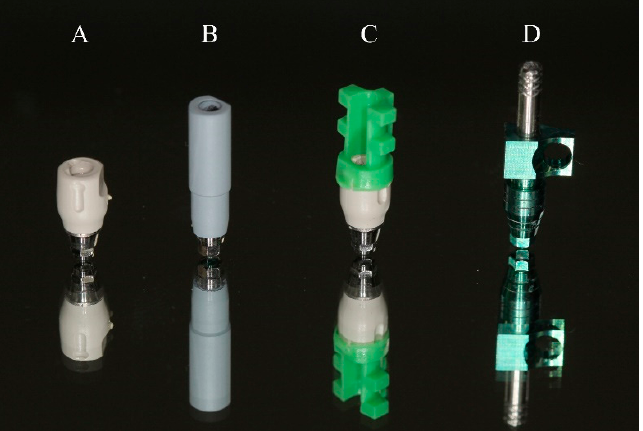
Figure 3. ( A ) PEEK short scan body; ( B ) PEEK long scan body; ( C ) PEEK short scan body with plastic cap; ( D ) pick-up coping.